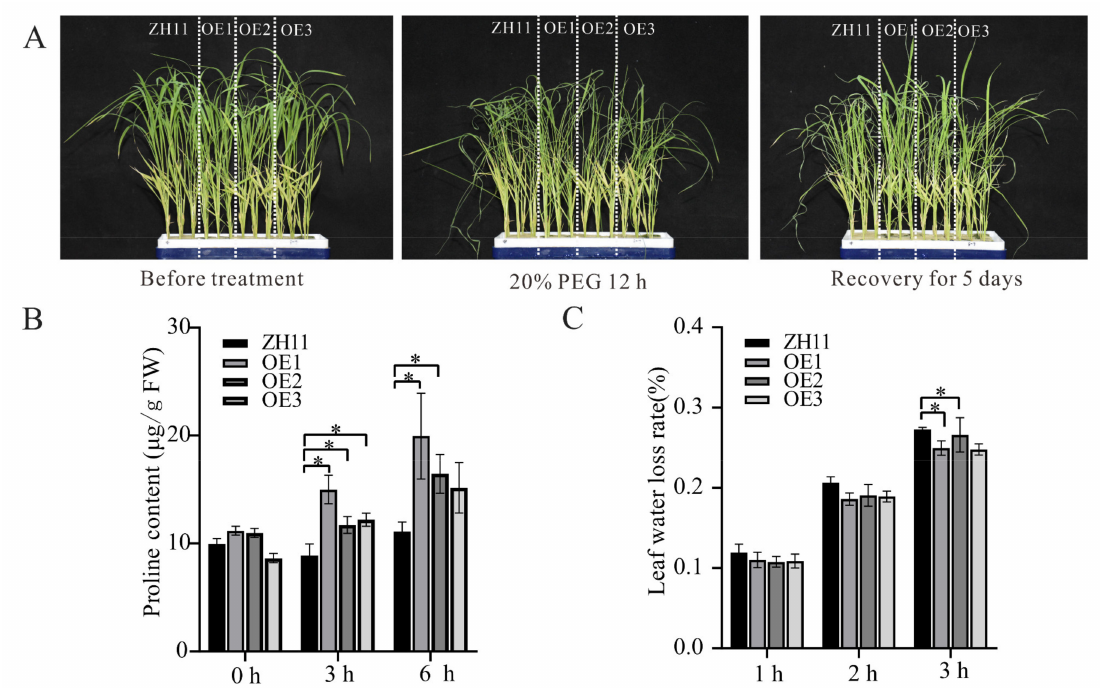
Figure 7. Simulated drought tolerance analysis of rice with ZmHsf05 -overexpression rice. ( A ) Phenotypic performance of transgenic rice before and after simulated drought treatment. Three transgenic rice ZmHsf05 -overexpression lines (OE1, OE2 and OE3) and wild-type ZH11 lines were cultured in 5-times-diluted Hoagland nutrient solution supplemented with 20% PEG6000. ( B ) Three-week-old rice seedlings were subjected to 25% PEG6000 simulated drought treatment for 3 h and 6 h to determine the content of proline. Three biological replicates were used for each experiment. Vertical bars indicate means ± SEs ( n = 3). *, p < 0.05 (Student’s t -test). ( C ) Three-week-old rice seedling leaves were subjected to 1 h, 2 h and 3 h in vitro leaf water loss rate